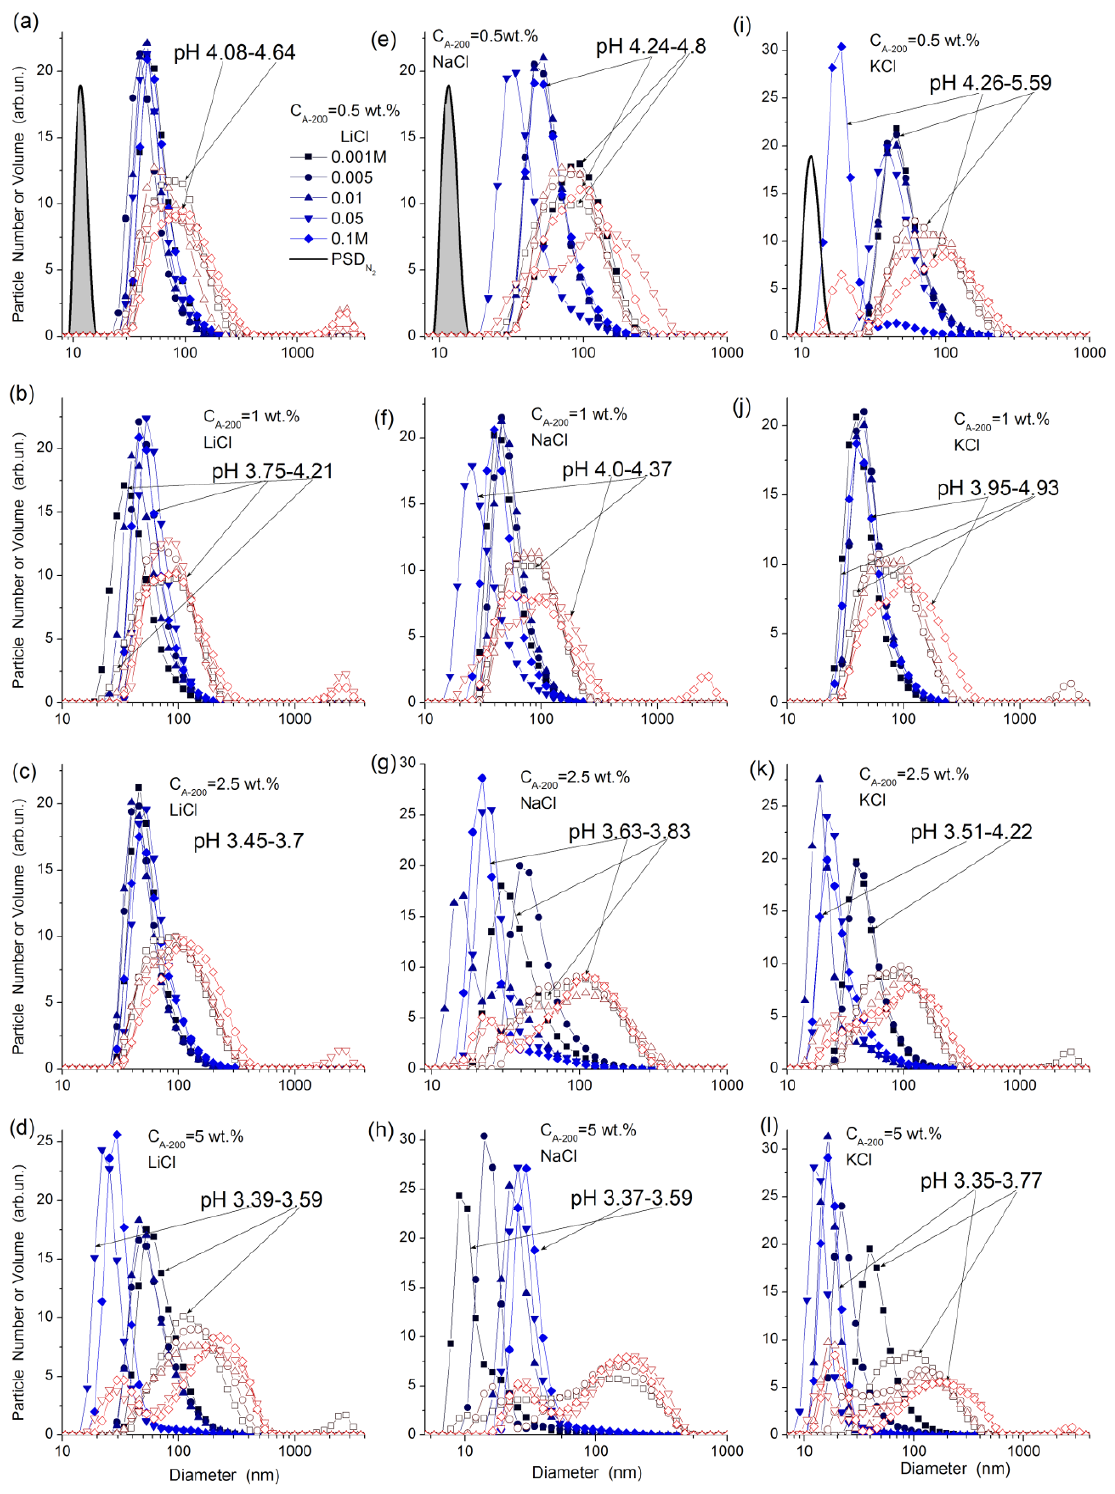
Figure 2. Particle size distributions with respect to the particle number (solid symbols) and volume (open symbols) at different content of (a-c) LiCl, (e-h) NaCl, (i-l) KCl and at C = (a, e, i) 0.5, (b, f, j) 1, (c, g, k) 2.5, and (d, h, l) 5 wt.% in the aqueous suspensions; (a, e, i) PSD A-200 is the primary particle size distribution of A-200 determined from nitrogen adsorption